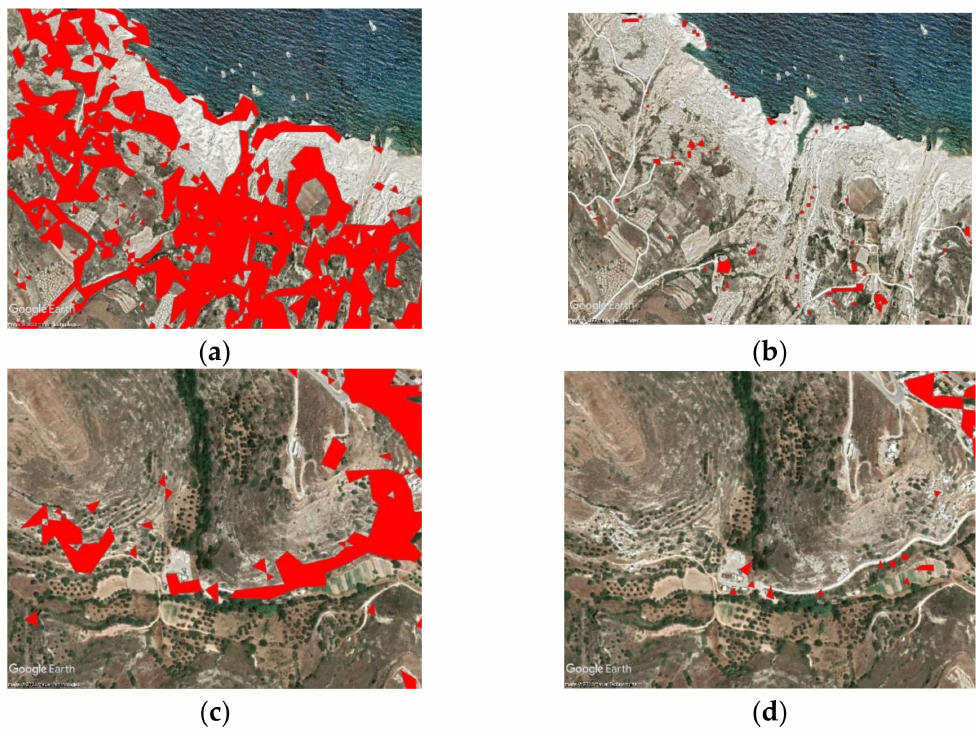
Figure 14. The images illustrating the indicative areas in Milos that were misclassified as built-up areas based on the existing ESM dataset ( a , c ), in contrast with the resulting RF products demonstrated a clear distinction between the urban environment and the bare land ( b , d ).